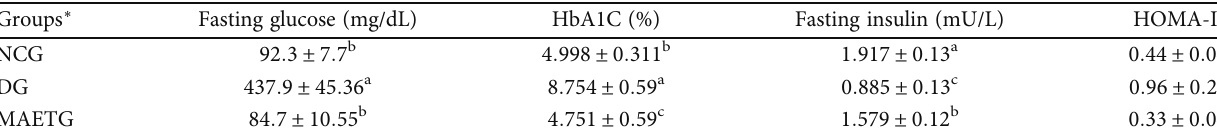
∗ Each group contained 10 rats. The mean results were expressed as mean ± SD . Di ff erent superscript letters (a, b, and c) denote signi fi cance while similar letters denote no signi fi cance between groups. The mean di ff erence is signi fi cant at p < 0 : 05 . HbA1C: glycated hemoglobin; HOMA-IR: homeostasis model assessment of insulin